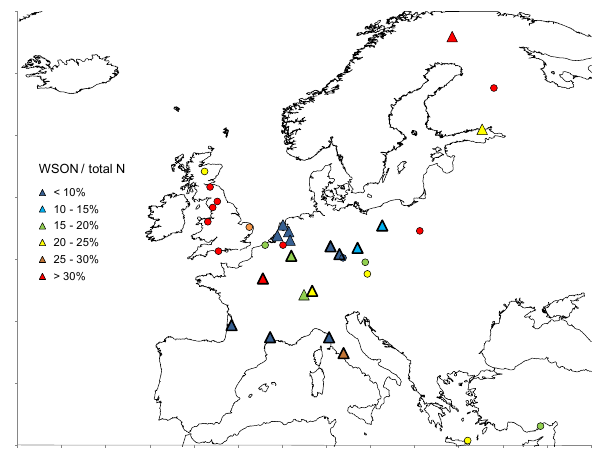
Fig. 5. WSON as % of total wet-deposited N across Europe, show- ing results from this study (triangles) and literature data (circles; see text for citations). “Level 1” sites from this study are shown with bold